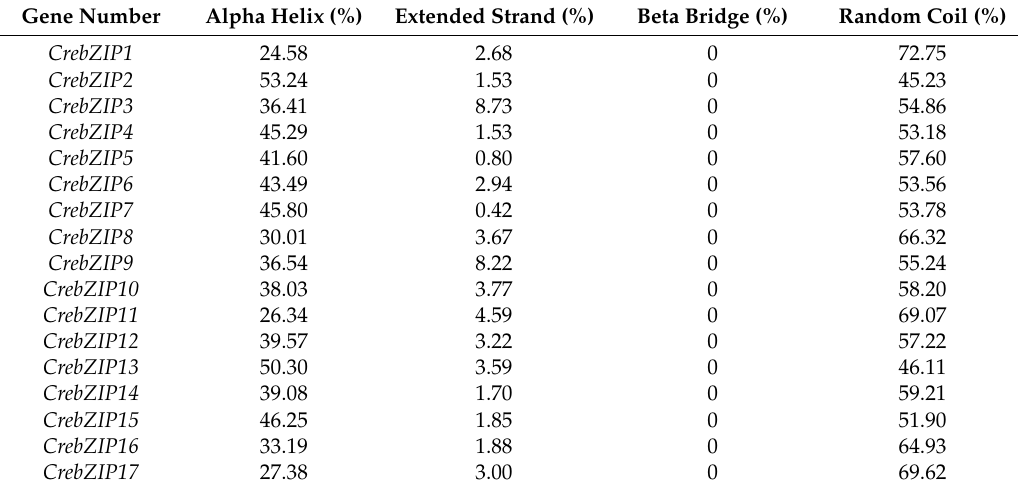
Table 2. Secondary structure of CrebZIP